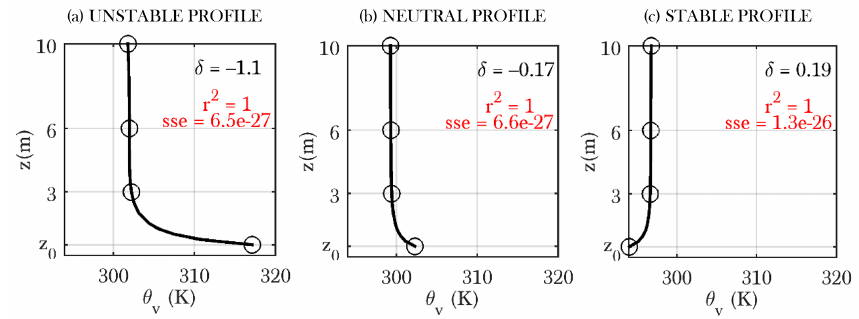
Figure B1. Vertical profiles of the virtual potential temperature ( θ v ) for different static stabilities. Values are taken from a moderate downslope event (25 July) at (a) 16:00UTC, (b) 18:30UTC and (c) 21:30UTC. The value of δ is shown in black, and the square of the multiple correlation coefficient ( r 2 ) and the sum of the squares due to error (sse) are shown in red, as a measure of the goodness of